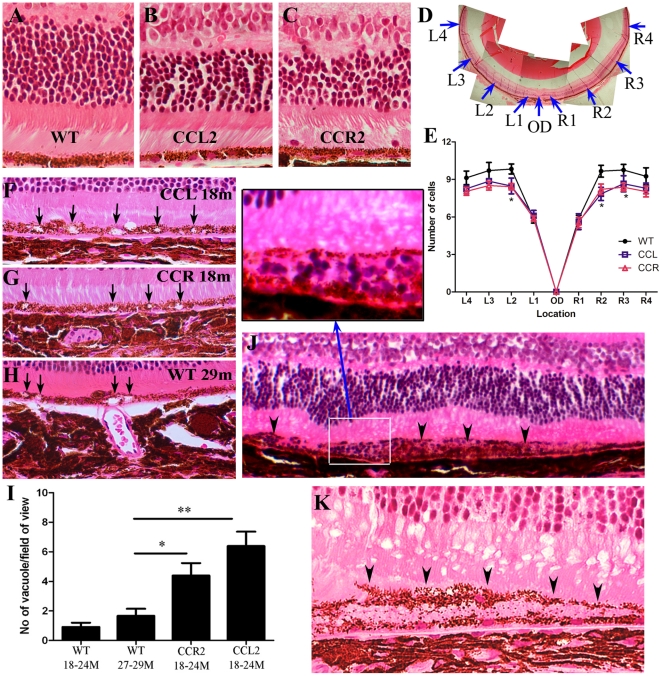
Histology of mouse eyes.Mouse eyes were taken from 18–24 months old mice and processed for H-E staining. A–C, representative images of a 22-month WT (A) a 22-month CCL2 KO (B) and a 22-month CCR2 KO (C) mouse showing photoreceptors. D & E, quantitative analysis of the number of photoreceptor nuclei. D, a schematic image showing the locations where the photoreceptor nuclei were counted. E, the numbers of photoreceptor in 20–24 months old mice WT, CCL2- or CCR2-deficient mice. *, P<0.05 compared to the WT mice at the same location . Mean ± SEM, n = 8–10 eyes, ANOVA (Kruskal-Wallis test) followed by Dunn's multiple comparison test. F–I, Representative images from aged CCL2 KO (F), CCR2 KO (G), and WT (H) mice showing RPE vacuolation (arrows). I, the number of RPE vacuoles in different strains of mice. Mean ± SEM, n = 12 eyes, *, P<0.05; **, P<0.01. ANOVA Dunn's multiple comparison test. J & K, retinal images from a 20-month (J) and a 24-month (K) CCL2 KO mouse showing areas of RPE cell damage (arrowheads) and inflammatory cell infiltration (insert in J). A layer of pigmented cells on top of degenerated (damaged) RPE cells was observed in K.